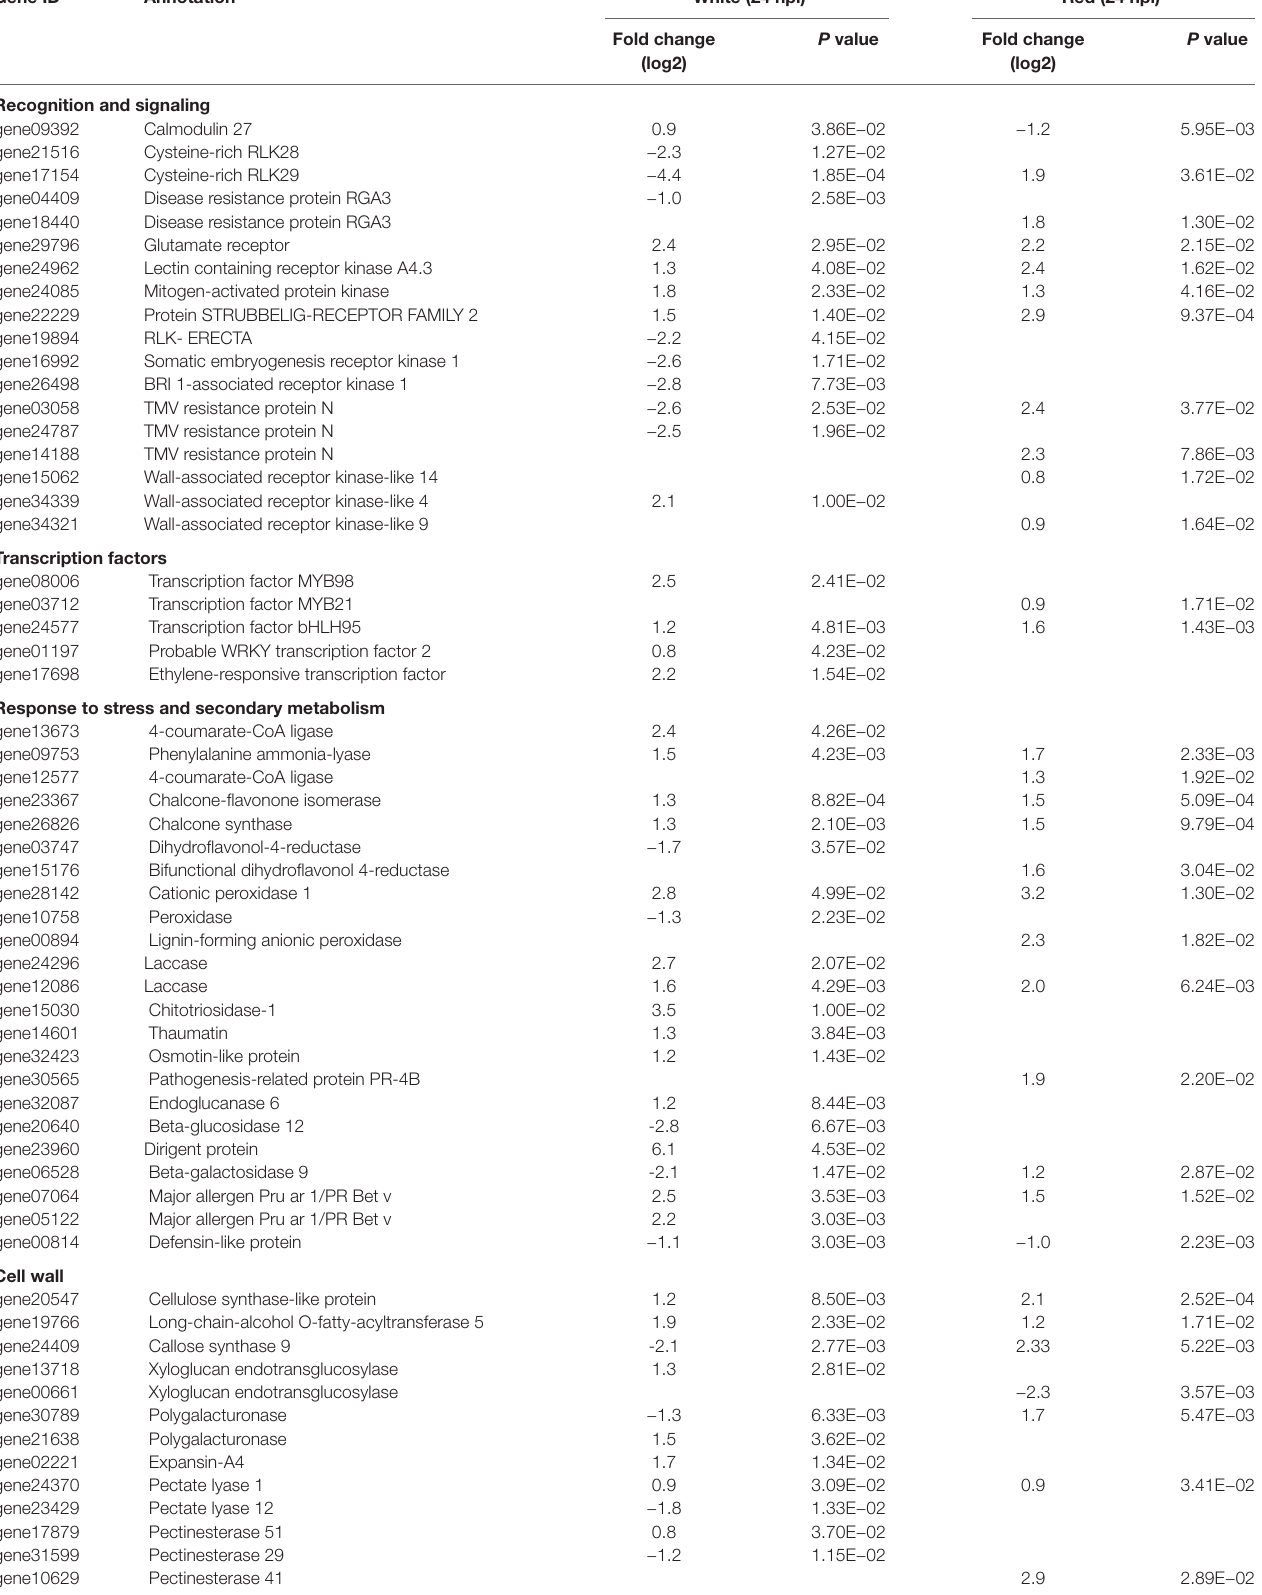
TABLE 1 | Selected Botrytis- induced genes in Fragaria vesca fruits at 24 hpi with P ≤ 0.05 and absolute fold change (log2) of